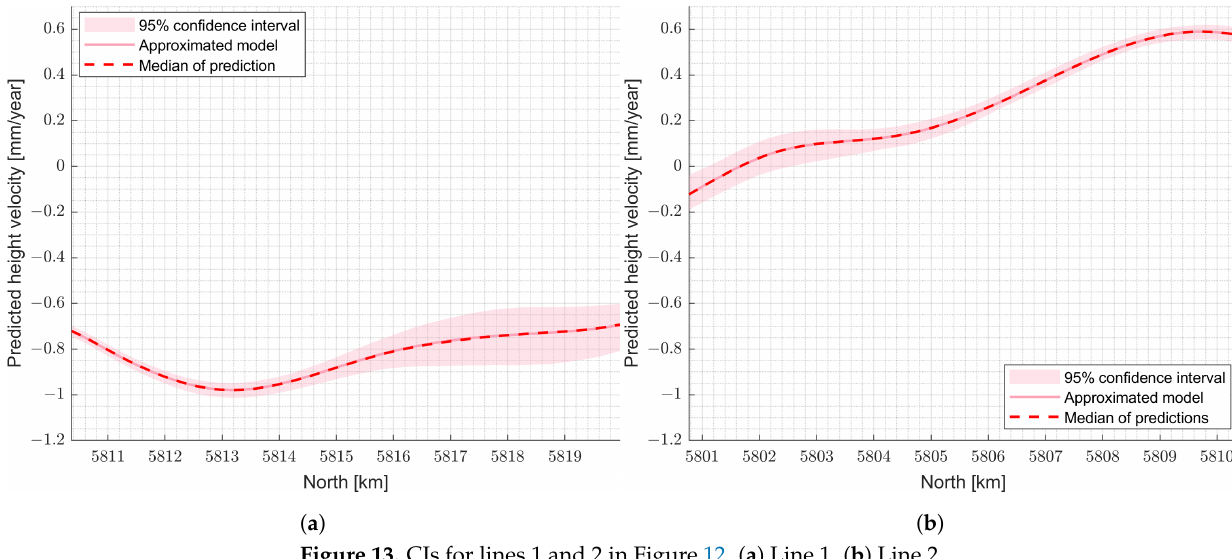
Figure 13. CIs for lines 1 and 2 in Figure 12. ( a ) Line 1. ( b ) Line